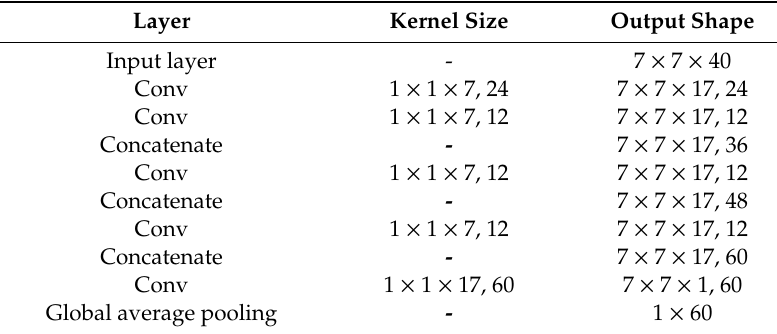
Table 4. Layer-wise summary of the 1D spectral branch.